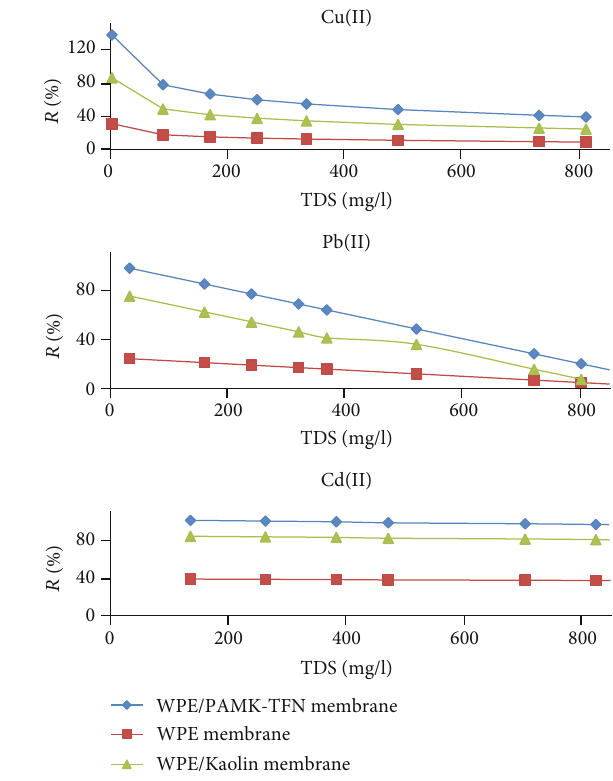
Figure 8: E ff ect of heavy metal feed concentration on WPS, WPS/kaolin, and WPE/PAMK-TFN membrane fl ow rate.